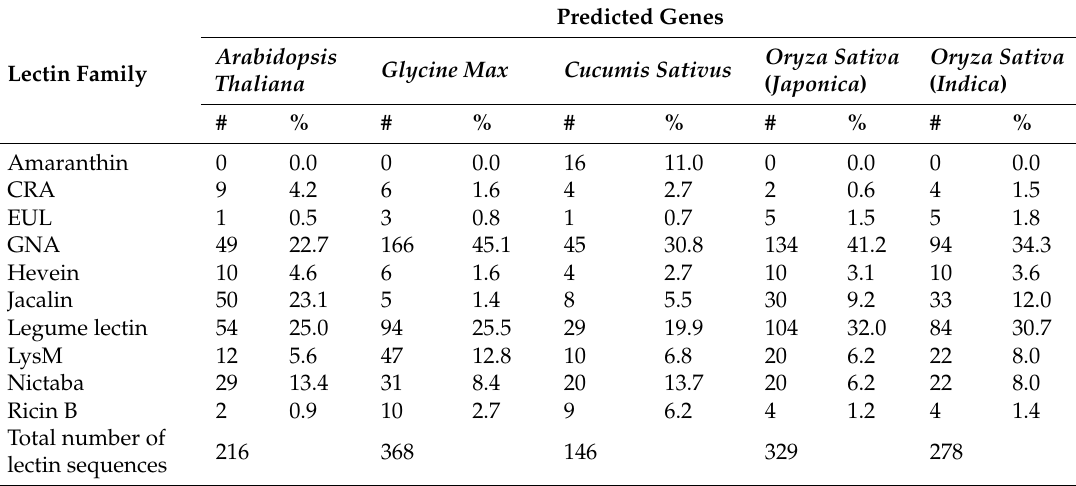
Table 1. Distribution of lectin genes in Arabidopsis, soybean, cucumber and rice. Predicted Genes Arabidopsis Oryza Glycine Max Cucumis Sativus Lectin Family Thaliana